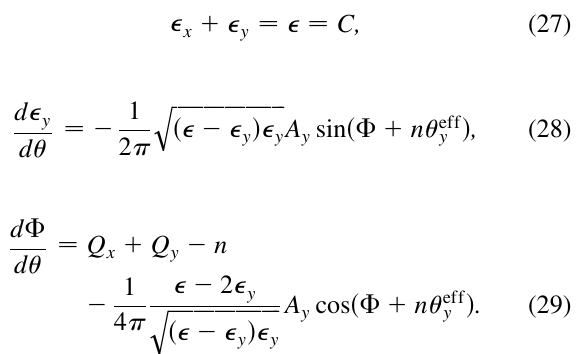
(cid:8) Q (cid:2) n . x y